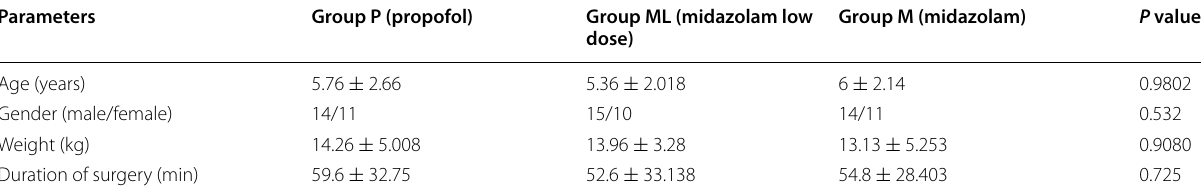
Values are presented as mean SD, * p value <0.05 statistically significant ± Table 3 Emergence time and emergence delirium